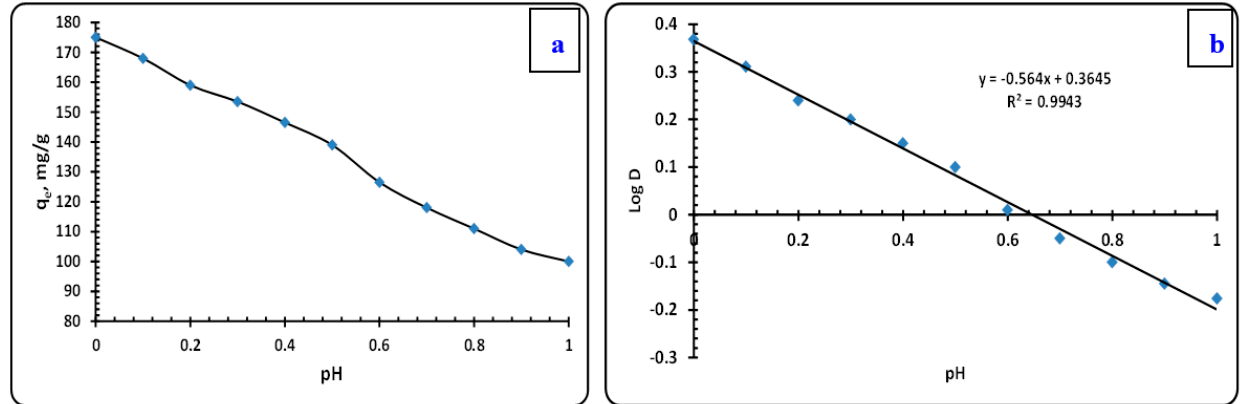
Figure 7. ( a ) The effect of pH on zirconium retention by the PPVP composite. ( b ) The slope regres- sion analysis diagram for zirconium ions retention by PPVP at different pH values. (Conditions: V: 50 mL, Zr concentration: 500 mg/L, m: 0.1 g, T: 25 º C, shaking time: 10 min.)